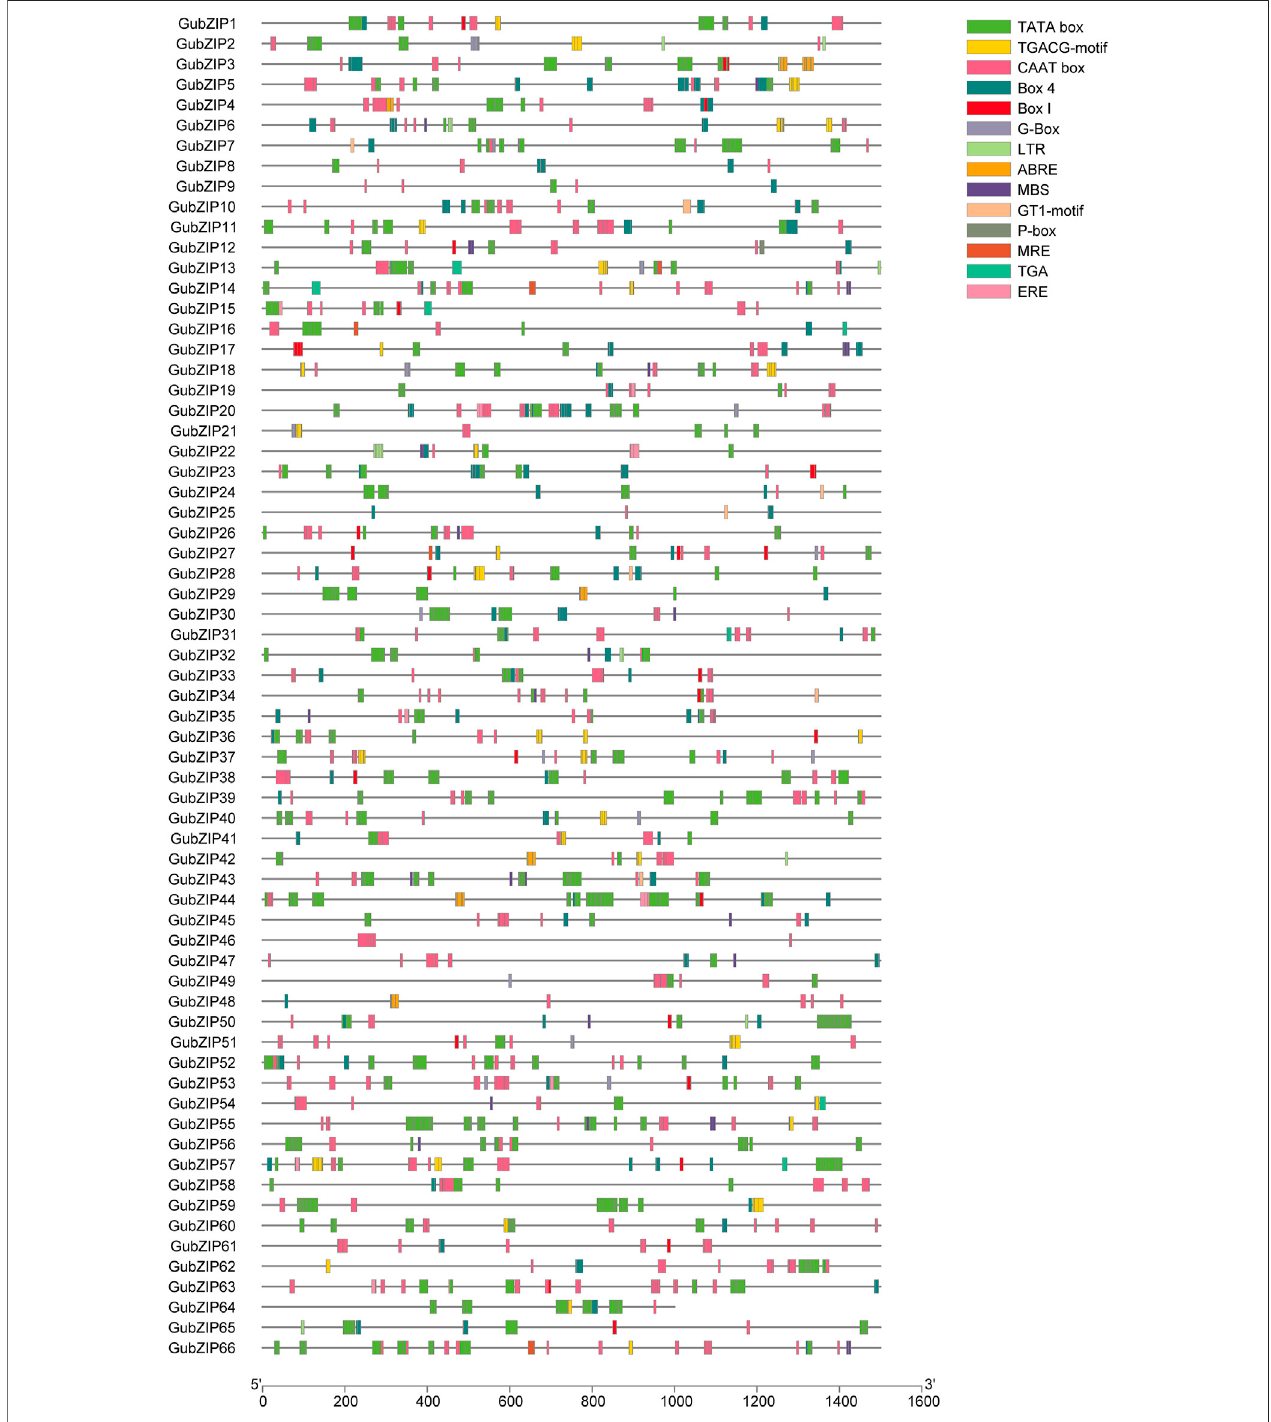
FIGURE 4 | Cis-regulatory element analysis of GubZIP gene promoter. The promoter sequence ( − 1,500 bp) of GubZIP genes ( − 1,000 bp for GubZIP64 ) was inferred on PlantPAN 3.0. The upstream length of each cis -regulatory element to the translation start point can be inferred from the scale at the bottom.